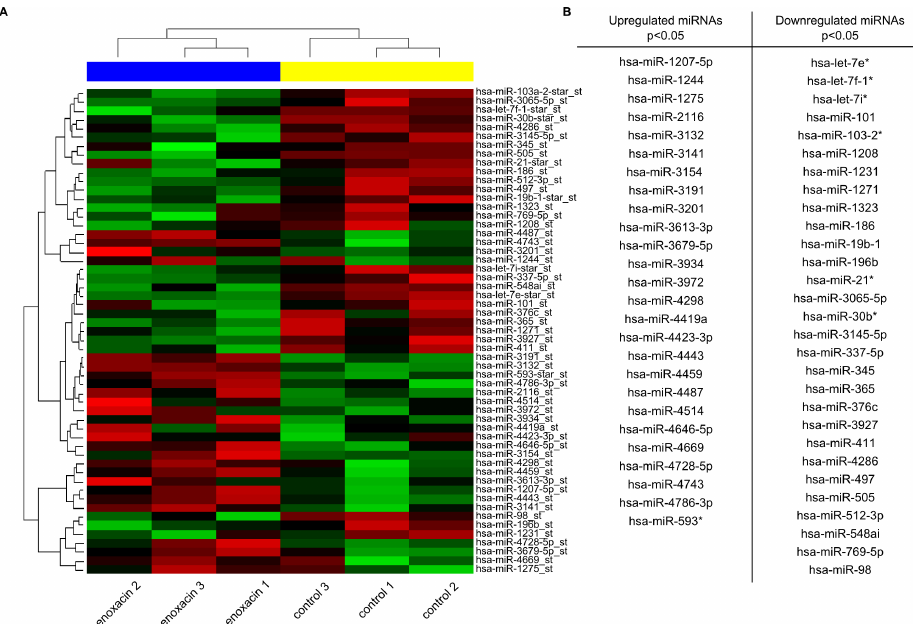
Fig 2. Enoxacin induces changes in the expression pattern of a large set of matured miRNAs in A375 cells. ( A ) miRNA expression profilingof control and enoxacin-treated A375 cells. Total RNA, including the small RNAs, was analyzedwith Affymetrix GeneChip miRNA 3.0 arrays. The heat map shows statistically significantchangesin the expressionof miRNAs in A375 melanomacells in responseto enoxacintreatment (p < 0.05;three independent experiments). ( B ) Matured miRNAs identifiedas significantly up- or down- regulatedin A375 melanomacells in responseto enoxacin(p <